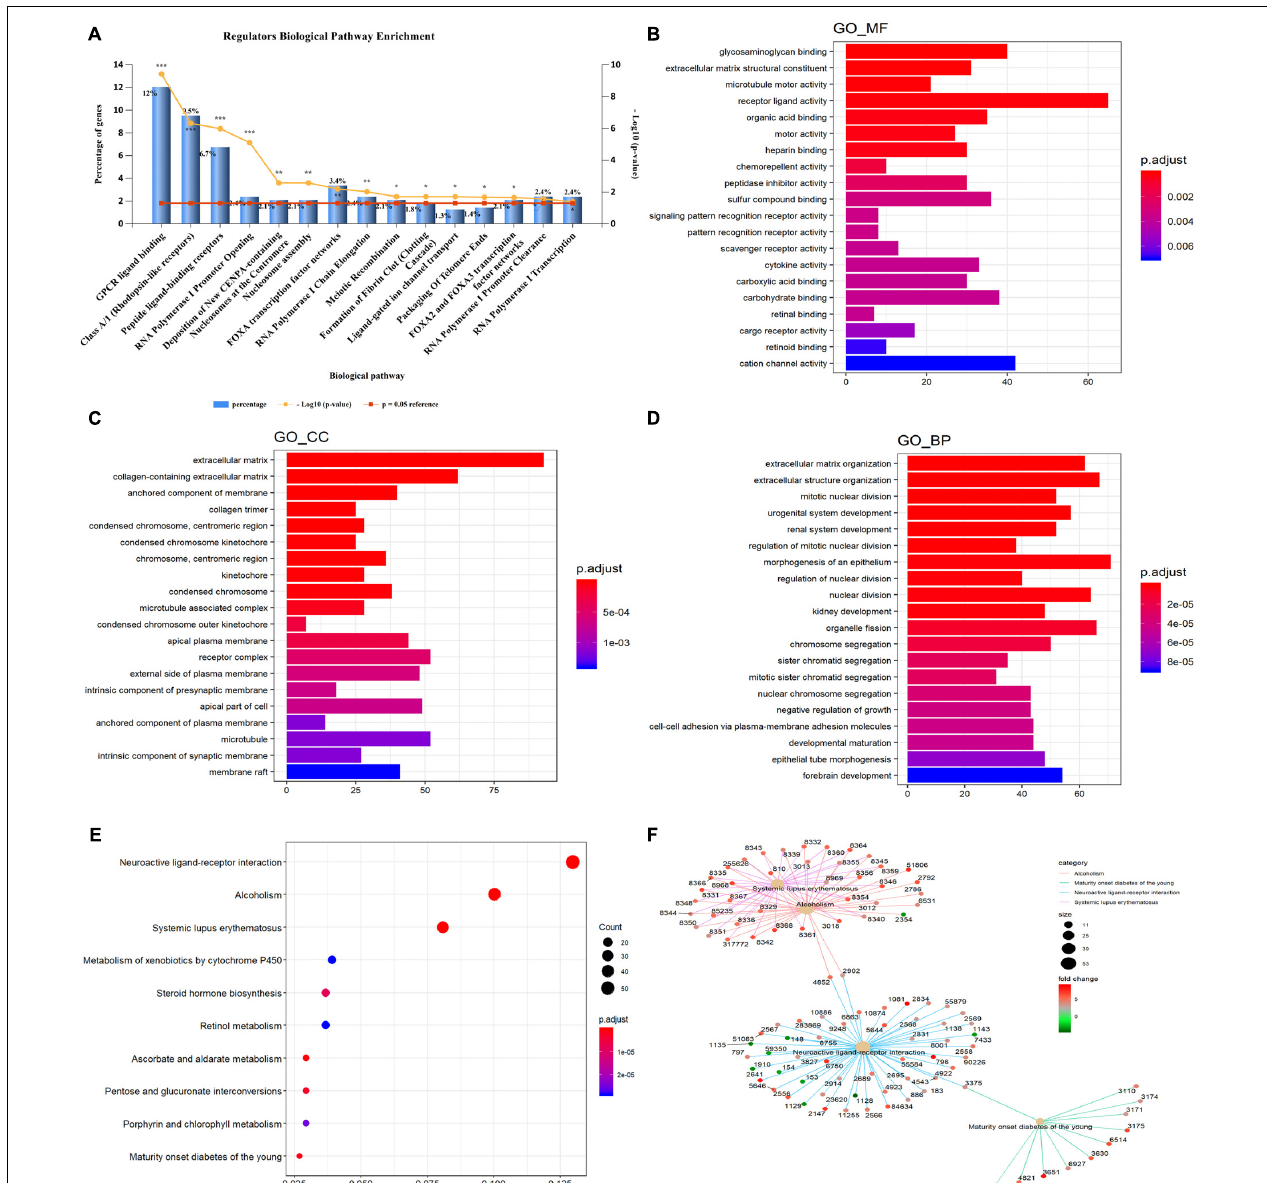
FIGURE 2 | GO and KEGG pathway enrichment analysis of DERNAs. (A) The statistical results of genes enriched in biological pathways. The y axis on the left represents the percentage of genes in each biological pathway, the y axis on the right is –log10( p value) of each enrichment pathway, and the x axis represents the pathways categories. GO analysis contains the molecular function (B) , cellular component (C) , biological process (D) , the y axis represents the number of target genes, and the x axis represents the GO categories. (E) The most important KEGG pathways in DERNAs. The y axis represents the pathways, and the x axis represents enriched gene numbers. The circle size represents the counts of genes in each pathway and the color means adjusted p value. (F) The netplot of KEGG pathways means enrichment of genes in different pathways. The number adjacent to nodes stands for gene ID. The color bar represents the fold change of genes in different pathways. * p < 0.05, ** p < 0.005, and *** p <